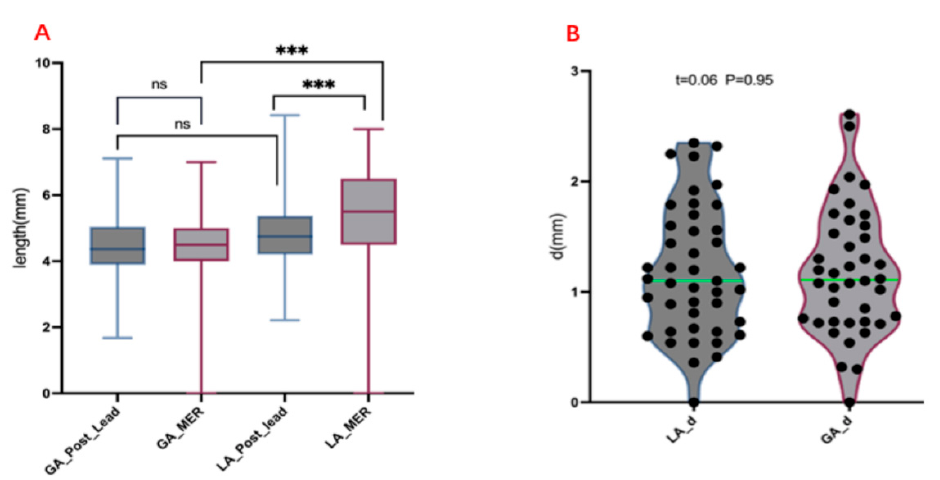
Figure 4. ( A ) Cross comparison of electrode length and MER length between two groups. ( B ) Comparison of the vector of deviation (d) between two groups. MER, microelectrode recording; d, vector of deviation; GA, general anesthesia; LA, local anesthesia; and ns, not significant; *** p < 0.01.